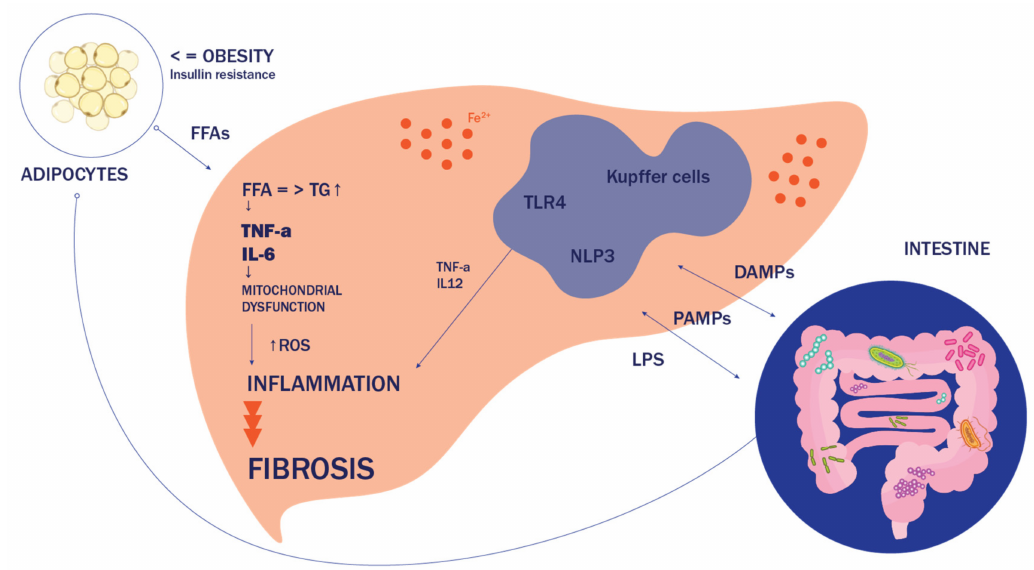
Figure 1. Molecular mechanisms in the pathophysiology of non-alcoholic fatty liver disease (NAFLD). Abbreviations: NAFLD, non-alcoholic fatty liver disease ; FFAs, free fatty acids; TNF- α , tumor necrosis factor alpha; IL-6, interleukin 6; IL12, interleukin 12; TG, triglycerides; ROS, reactive oxygen species; LPS, lipopolysaccharide; PAMPs, pathogen-associated molecular patterns; DAMPs, damage-associated molecular patterns; TLR4, toll-like receptors; NLP3, NOD-, LRR-, and pyrin domain-containing protein